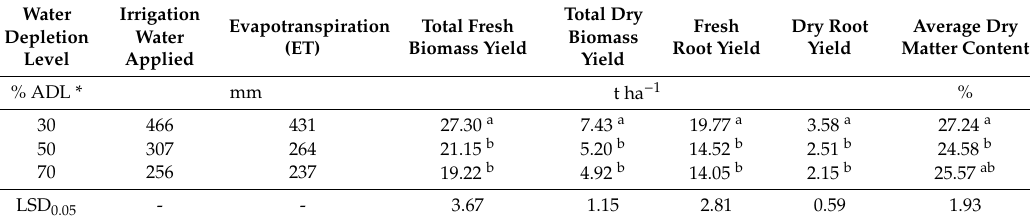
Table 1. Total irrigation, evapotranspiration, yield, and root dry matter content of Pelargonium sidoides under well-watered and water-stressed conditions.